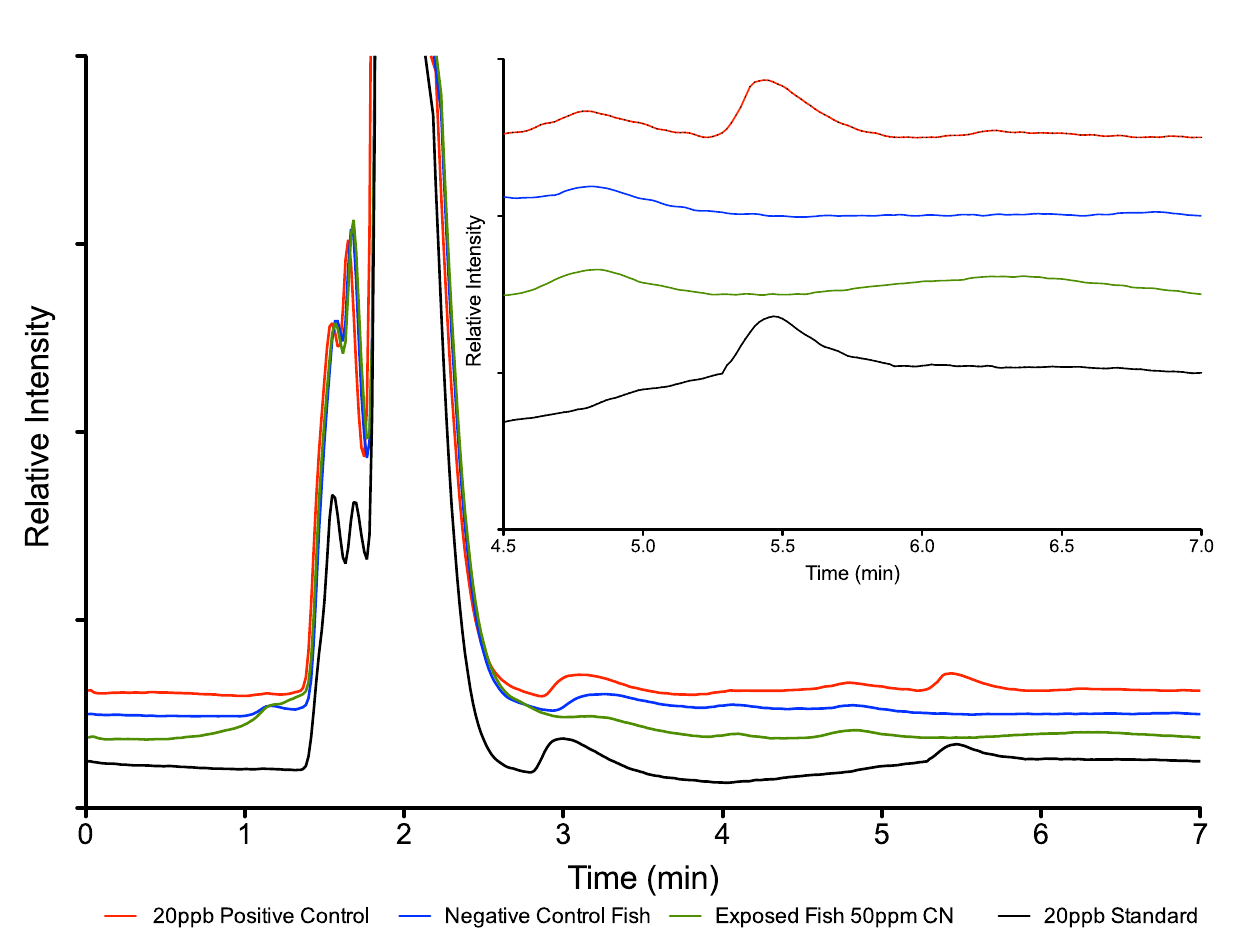
Fig 2. Typical chromatograms of HPLC-UV method. From bottom to top, a 20 μ g/L standard, a water sample from a control fish (no cyanide exposure), a water sample from an exposed fish from 01-13-2017 and a water sample positive control 3, spiked to 20 μ g/L thiocyanate produced by the HPLC method. The 20 μ g/L standard and spiked water sample show a clear thiocyanate peak with a retention time of about 5.5 minutes (see dashed box). The control fish and exposed fish show no peak at the same retention time. Graphs are stacked to show